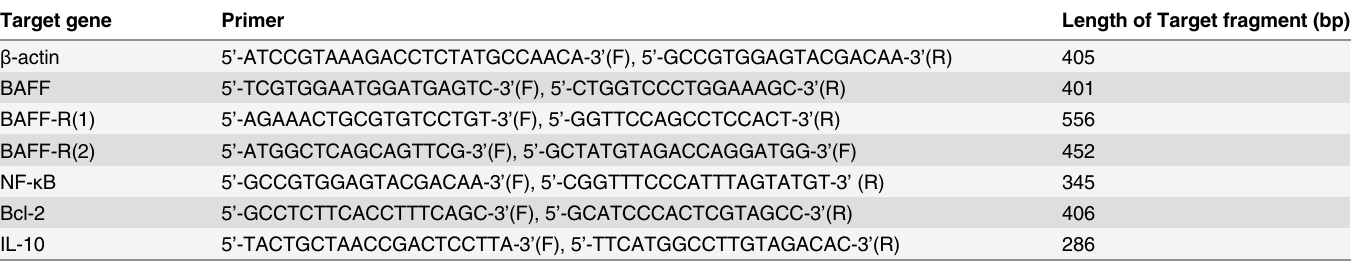
Table 1. Primers for the Target Genes and β -actin Used in RT-PCR. Target